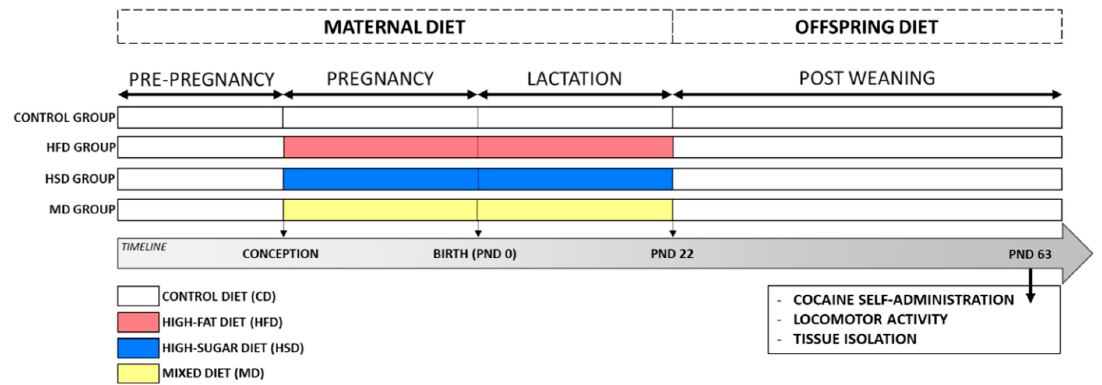
Figure 1. Experimental design and timeline. Dams were fed a control diet (CD) or one of the three modified diets: high-fat (HFD), high-sugar (HSD), or mixed (MD; rich in carbohydrate and fat) during pregnancy and lactation. Female offspring were divided into three cohorts and at postnatal day (PND) 63, they were assessed by tissue isolation and biochemical analyses, via the cocaine self-administration study and for locomotor activity.